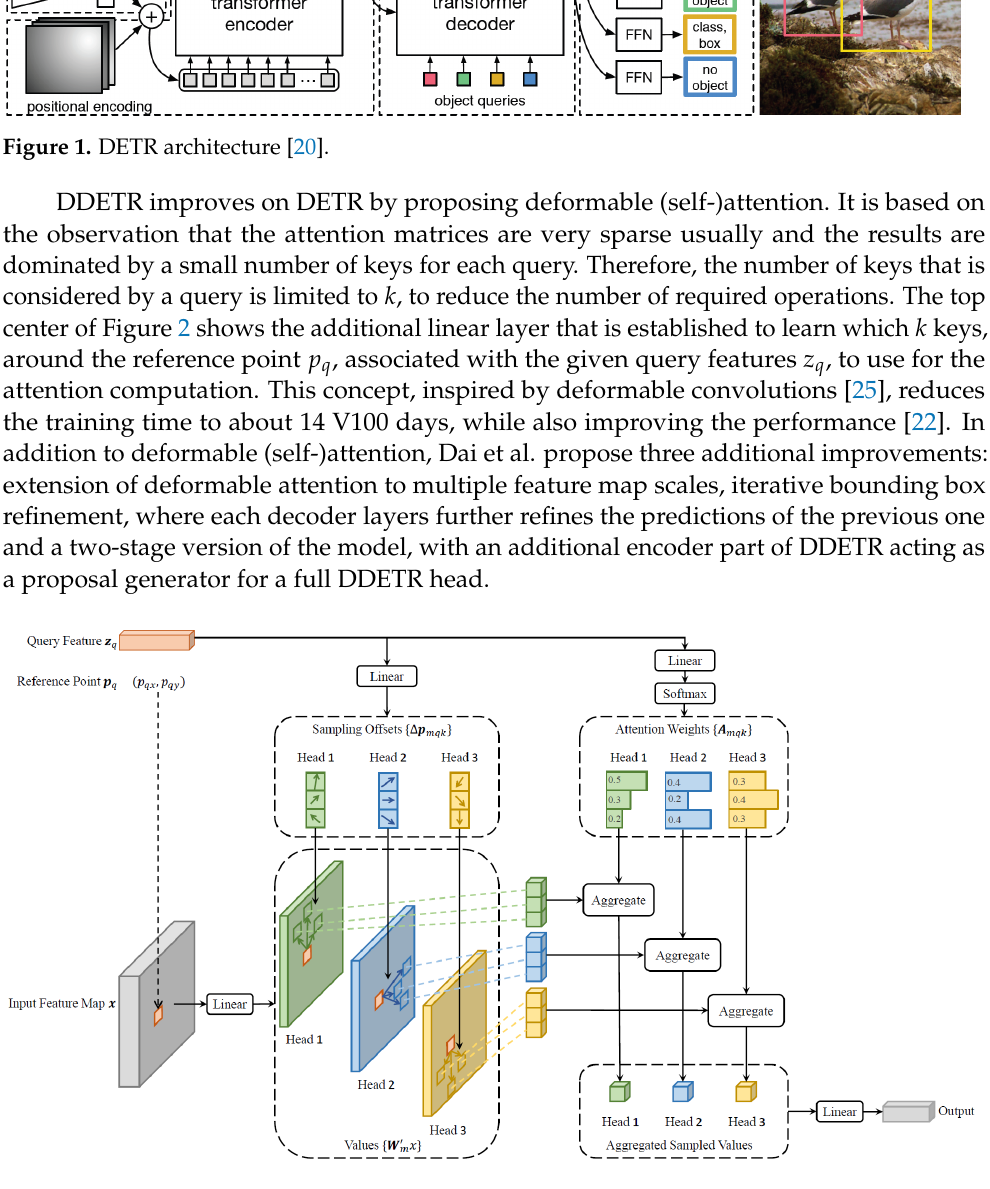
Figure 2. Illustration of the deformable (self-)attention module